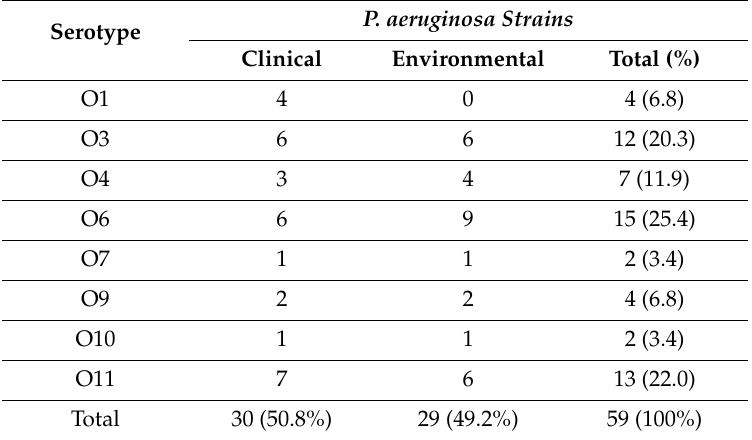
Table 1. Serotypes of Pseudomonas aeruginosa among the clinical and environmental strains used in this study.